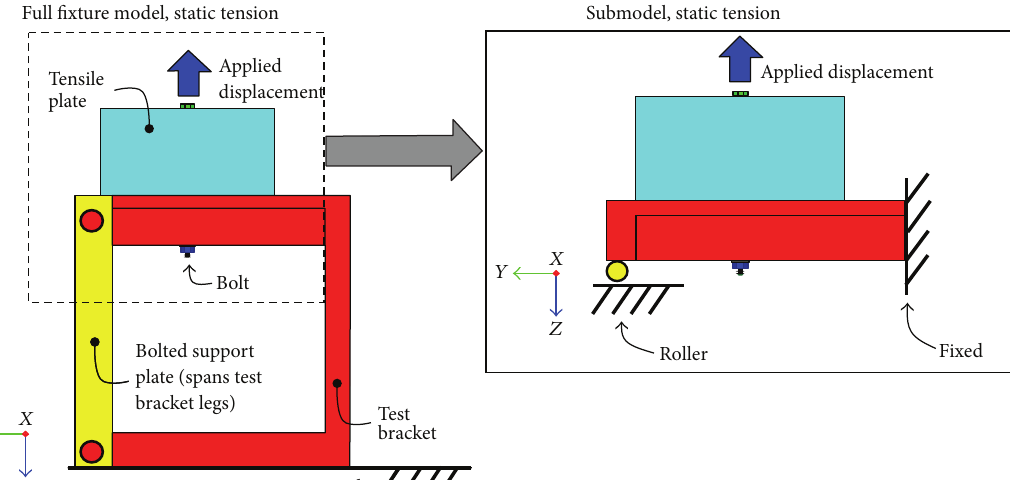
Figure 3: Submodel of static tension test.